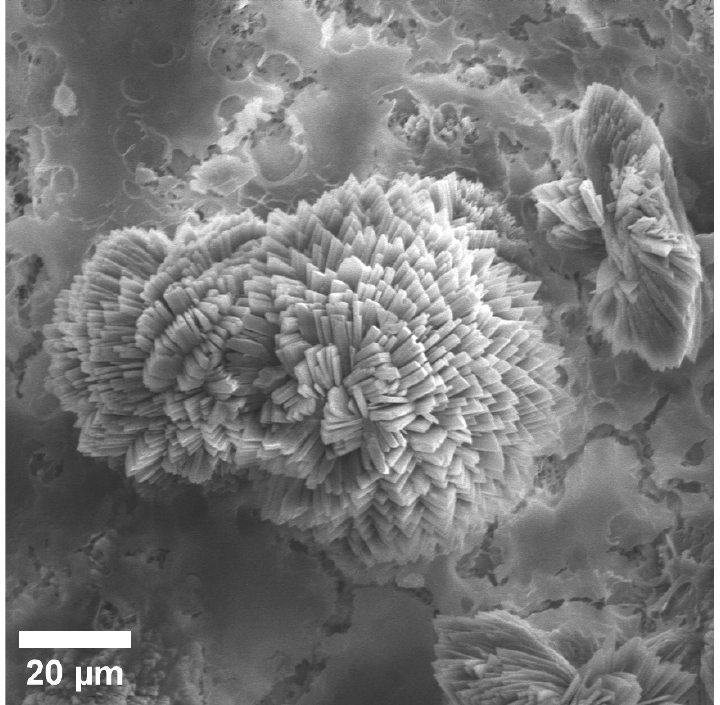
Figure 9. SEM image of multiple lamellae making up spherical highlights.